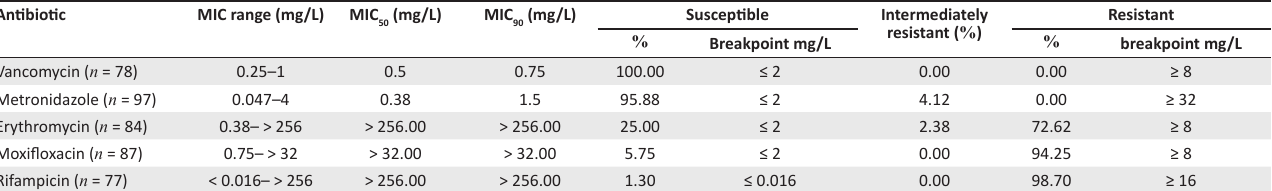
TABLE 2: Multi-drug resistance by ribotype. Ribotype Sensitive to all